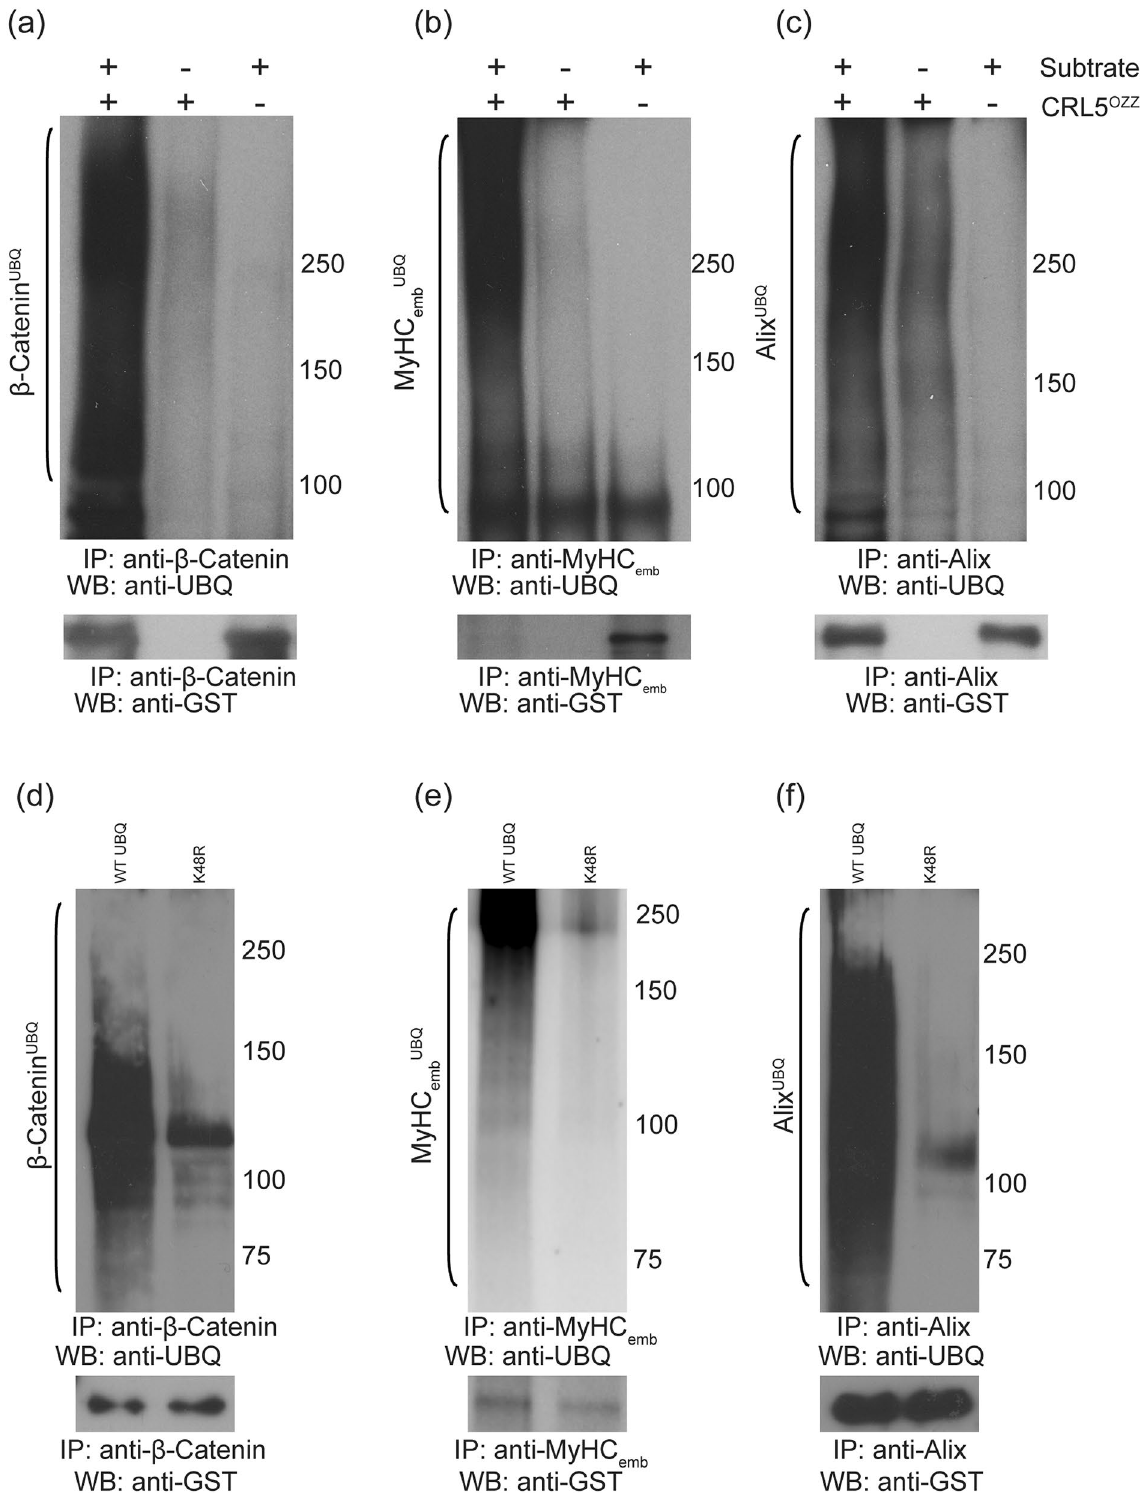
Figure 7. In vitro ubiquitination of recombinant β-catenin, MyHC emb and Alix mediated by CRL5 Ozz . ( a , d ) GST-tagged-β-catenin, ( b , e ) MyHC emb fragment (1041–1941 a.a.) and ( c , f ) Alix was incubated with CRL5 Ozz and either native ubiquitin or mutant Ub (K48R). In the presence of native ubiquitin and CRL5 Ozz , β-catenin or MyHC emb or Alix were efficiently ubiquitinated. If the assay was performed in the presence of Ub K48R, the ubiquitination was reduced to background levels, demonstrating that CRL5 Ozz polyubiquitinated β-catenin, MyHC emb and Alix. ( a – c ) CRL5 Ozz efficiently ubiquitinated β-catenin, MyHC emb and Alix (lane 1). The specificity of the reaction was confirmed by omitting either the substrate (lane 2) or the CRL5 Ozz complex (lane 3) from the ubiquitination assay, which significantly reduced the Ub-substrate products. ( d – f ) In the presence of native ubiquitin, CRL5 Ozz efficiently ubiquitinated its substrates (lane 1). Instead, by using K48R Ub mutant in the ubiquitination reaction, the ubiquitination of the substrates was significantly reduced (lane